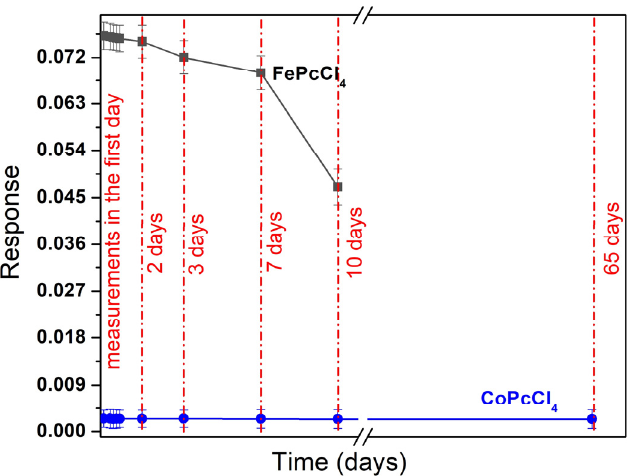
Figure 10. 2D and 3D AFM images of FePcCl 4 ( a , c ) and CoPcCl 4 films ( b , d ).